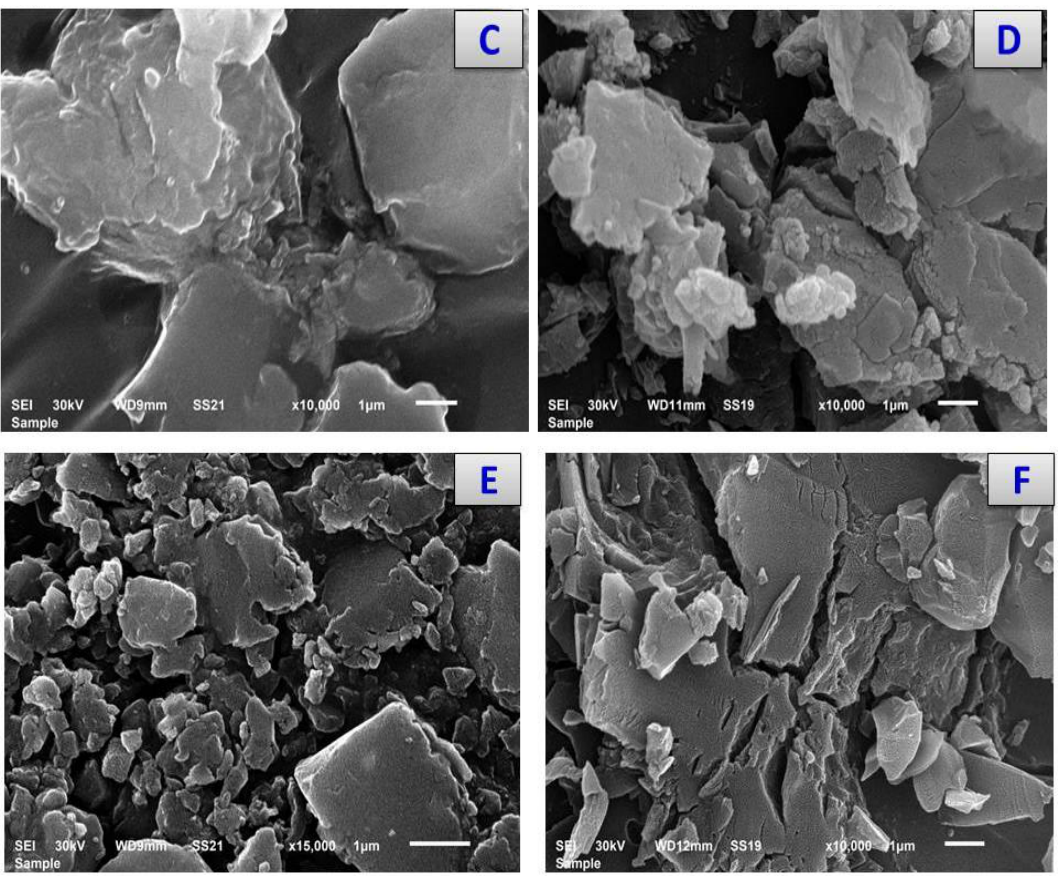
Figure 6. Scanning electron microscopy of ( A ) Cfotax, ( B ) cefotax/Ca, ( C ) cefotax/Cr, ( D ) cefotax/Cu, ( E ) cefotax/Zn, and ( F ) cefotax/Se. (1 µm).